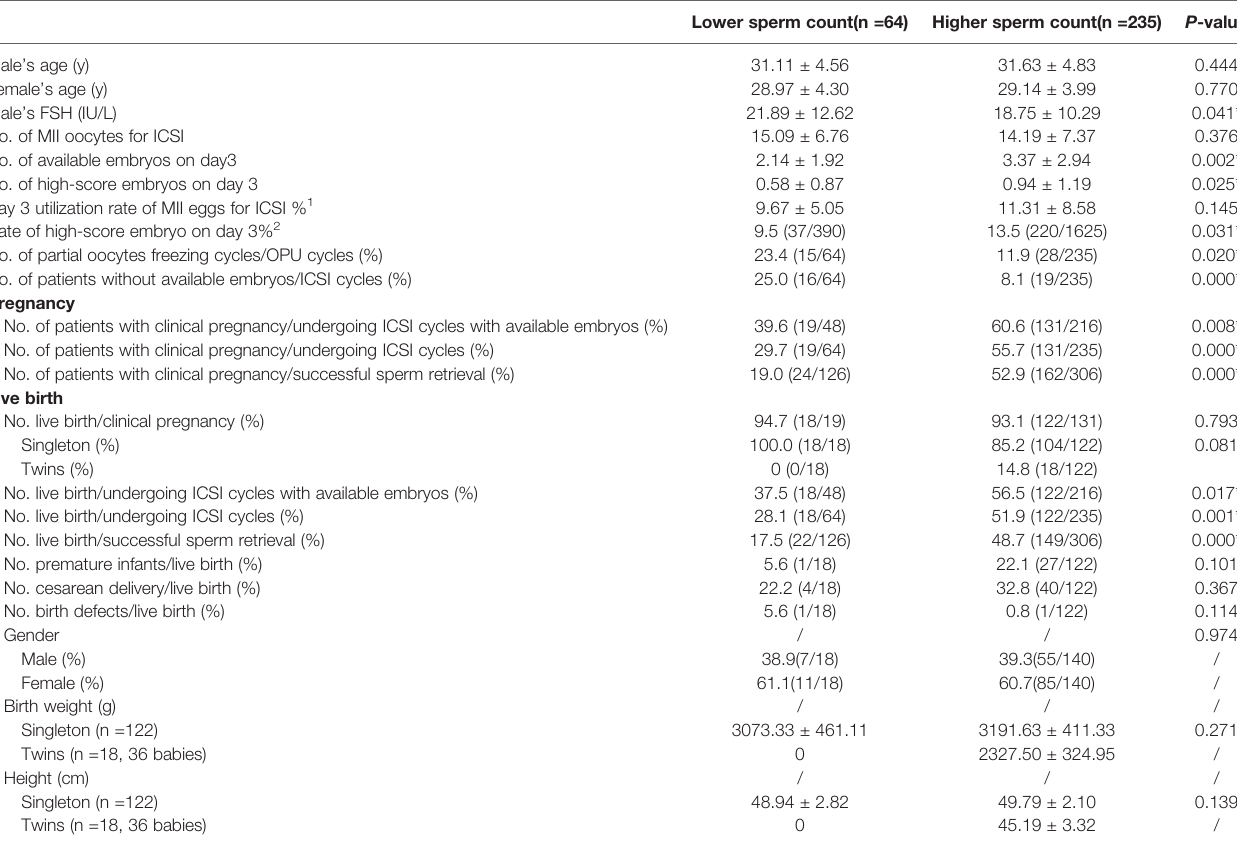
Lower sperm count(n =64) Higher sperm count(n =235) P -value